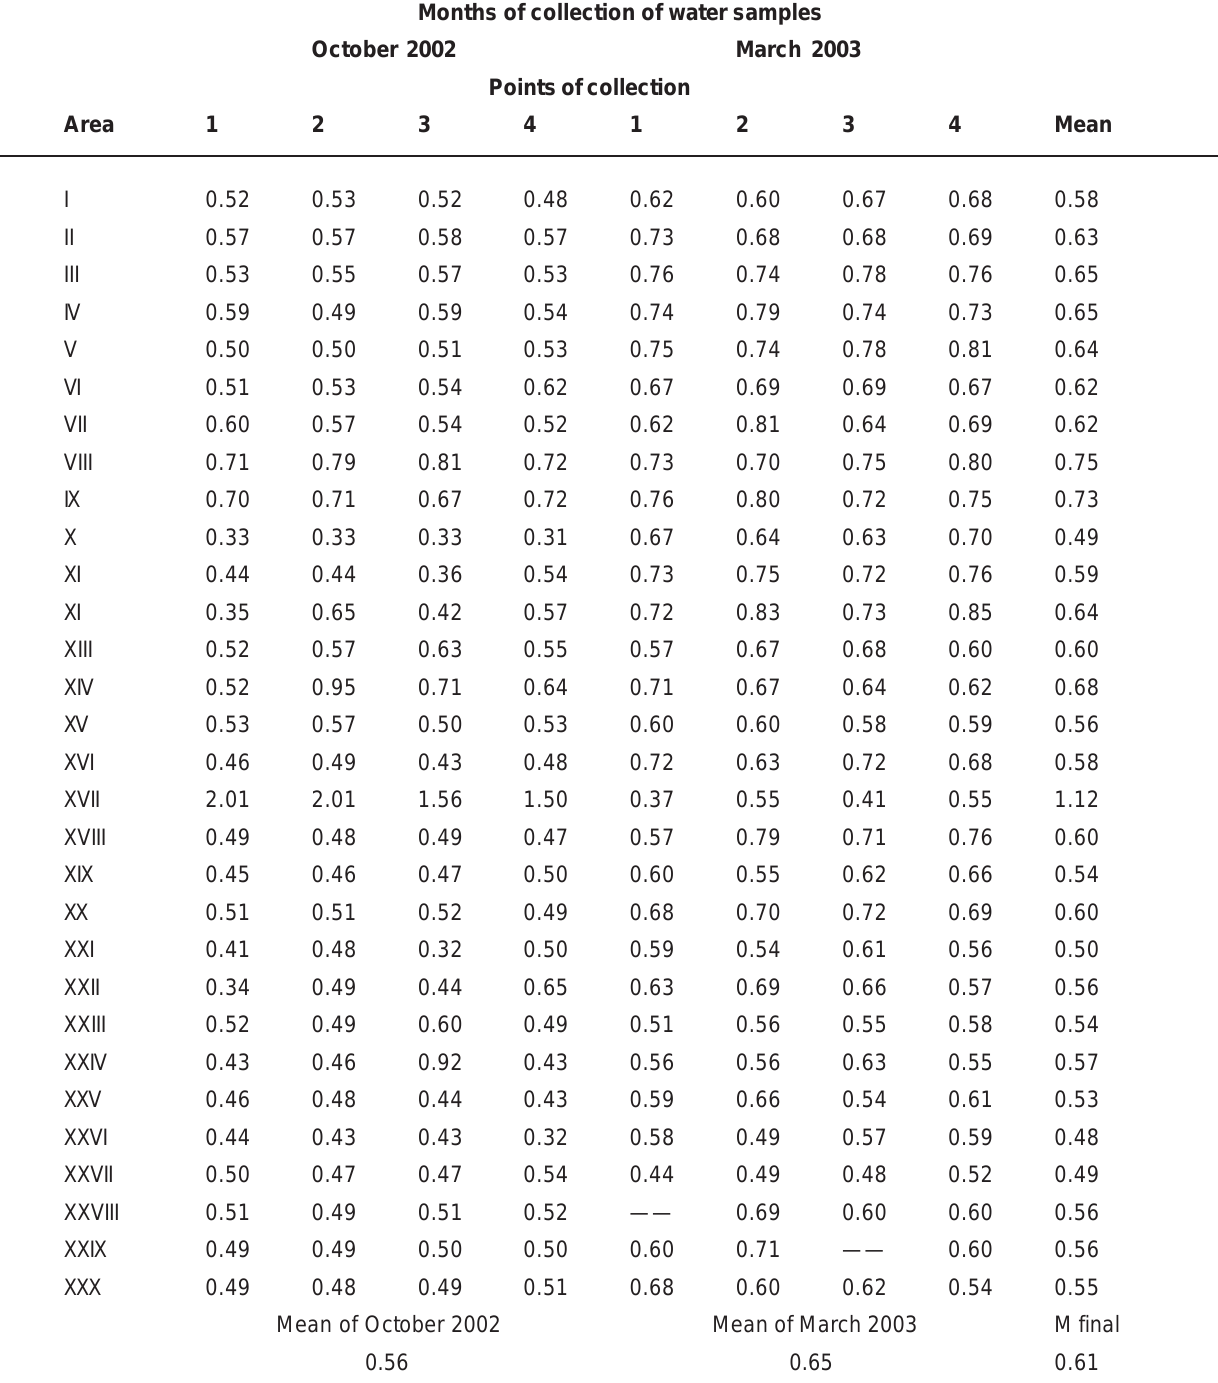
TABLE 1 - Fluoride concentration in the water samples collected in October 2002 and March 2003, at 4 points of 30 areas supplied by ETA (Sector I) in Bauru, SP,